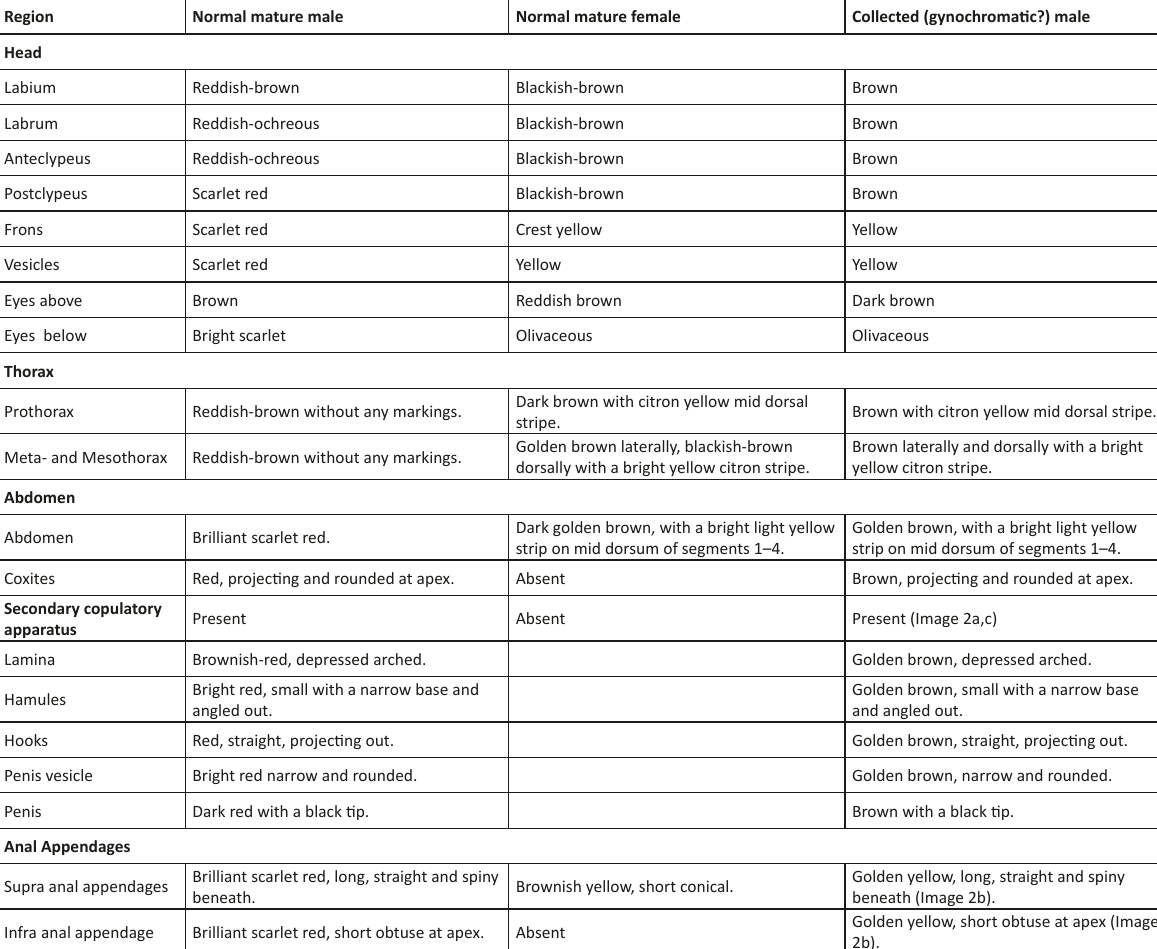
Table 1. A comparative account of the colour patterning between normal mature male, normal mature female and the collected (gynochromatic?) male of Rhodothemis rufa (Image 1c). Region Normal mature male Normal mature female Collected (gynochromatic?) male